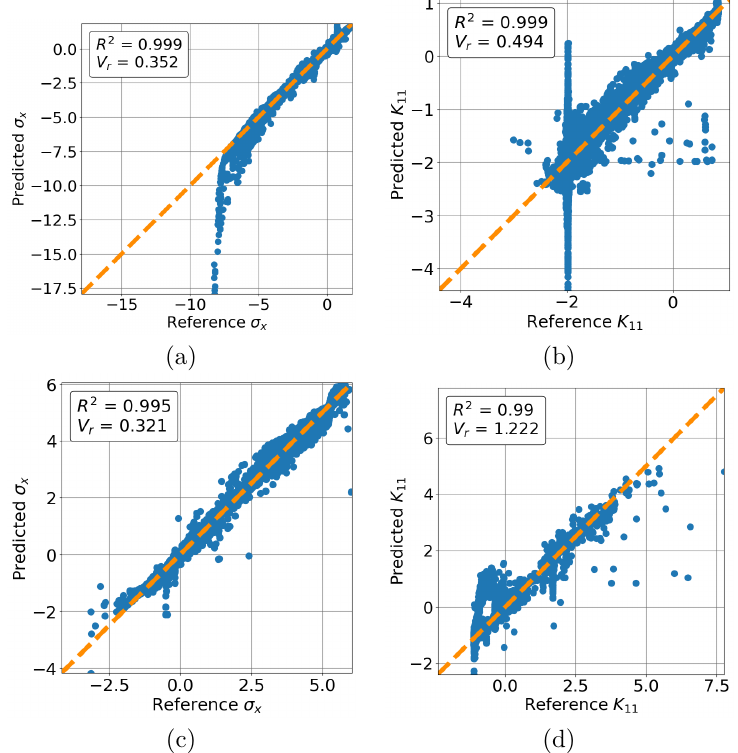
Figure 6. ResNet results for: (a) stress component σ component σ in CF 1, and (d) stiffness component K x